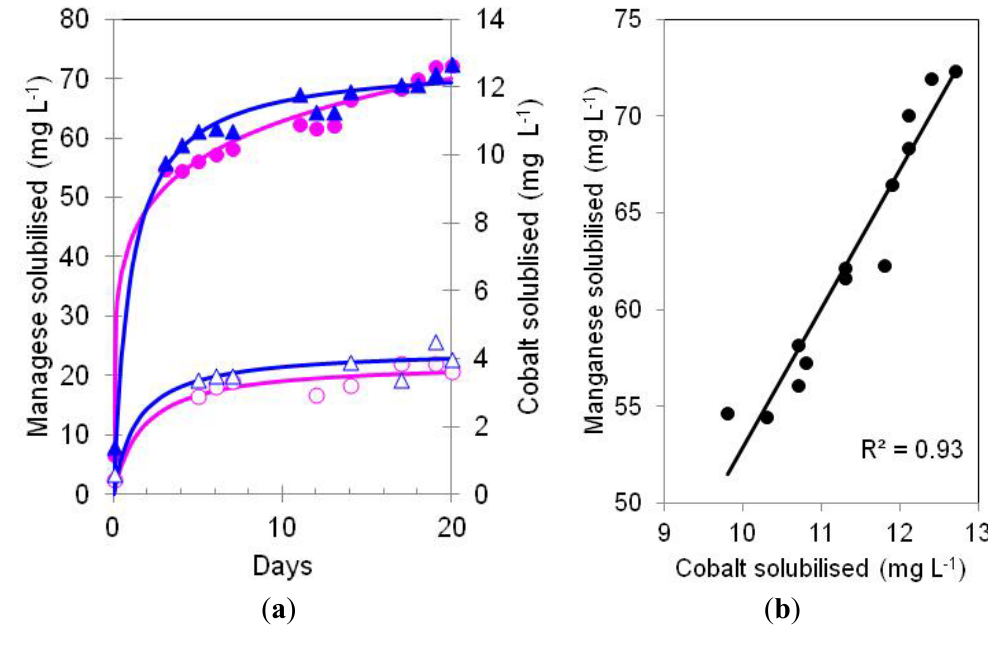
Figure 3. ( a ) Changes in concentrations of soluble manganese ( ● , ○ ) and cobalt ( ▲ , Δ ) in bioreactor cultures of At. ferrooxidans containing Ni laterite ore and elemental sulphur, incubated either under anoxic (solid symbols) or aerobic (open symbols)